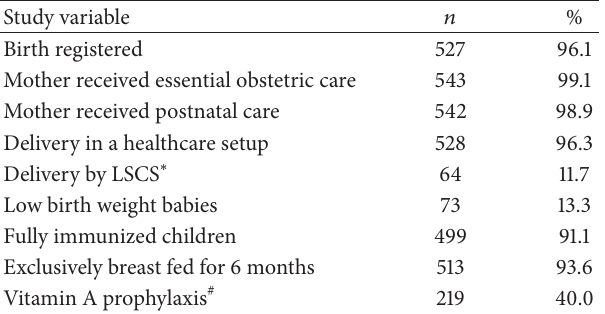
Table 3: Status of child health interventions in the study area before the implementation of family centered approach ( 𝑛 = 548 ).